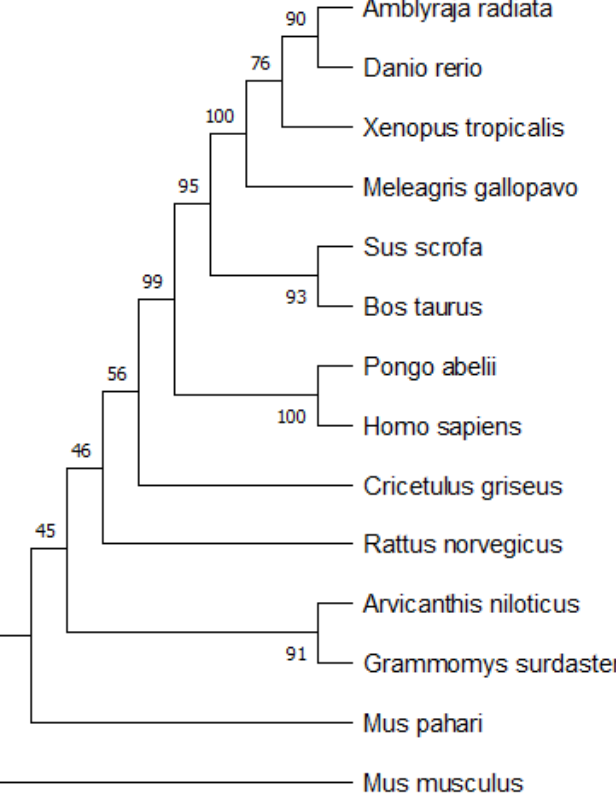
Figure 20. A neighbor-joining tree with 1000-times bootstrap analysis of the primary sequences by using MEGA 11 software